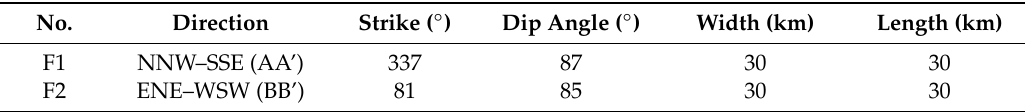
Table 2. Geometric parameters of the fault model.